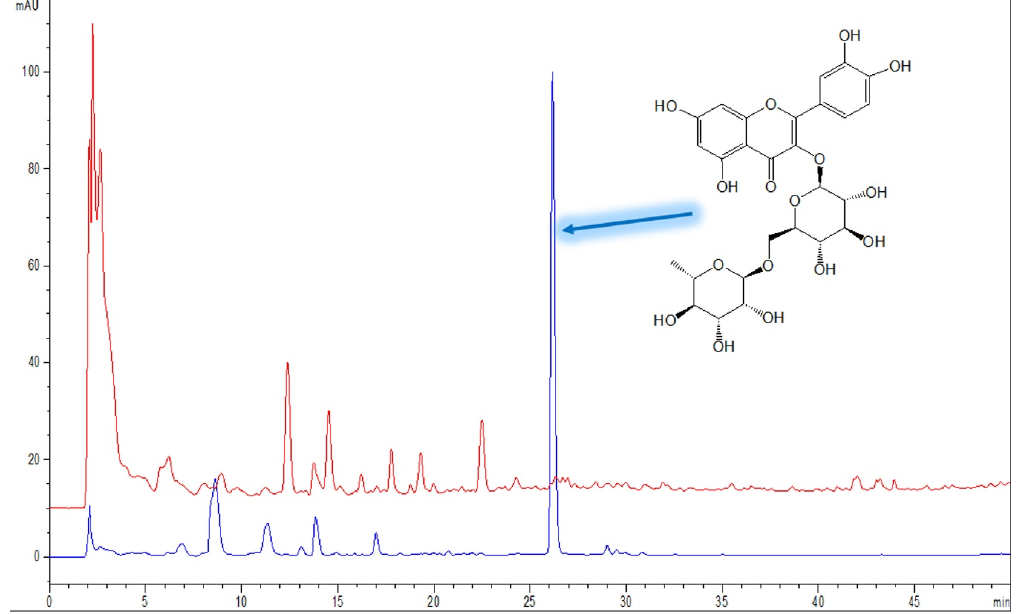
Figure 1. HPLC profiles of crude methanolic extracts of M. oleifera (top panel) and M. stenopetala (lower panel). The HPLC analysis was based on 5 mg/mL solution of crude leaves extracts as described in the experimental section. Notice the presence of rutin (structure shown) only in M. stenopetala